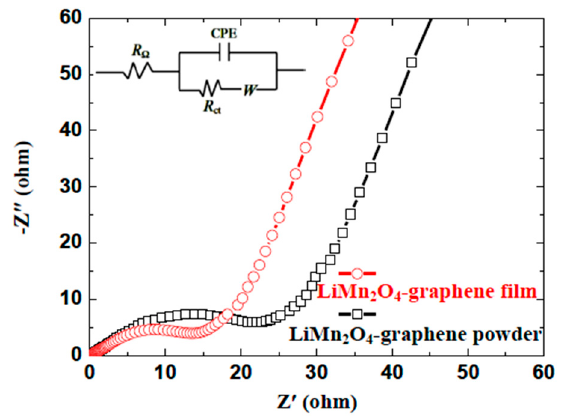
Figure 8. Nyquist plots of the LiMn 2 O 4 -graphene film and LiMn 2 O 4 -graphene powder cathodes after the first cycle showing the whole frequency region of 100 kHz to 0.01 Hz.